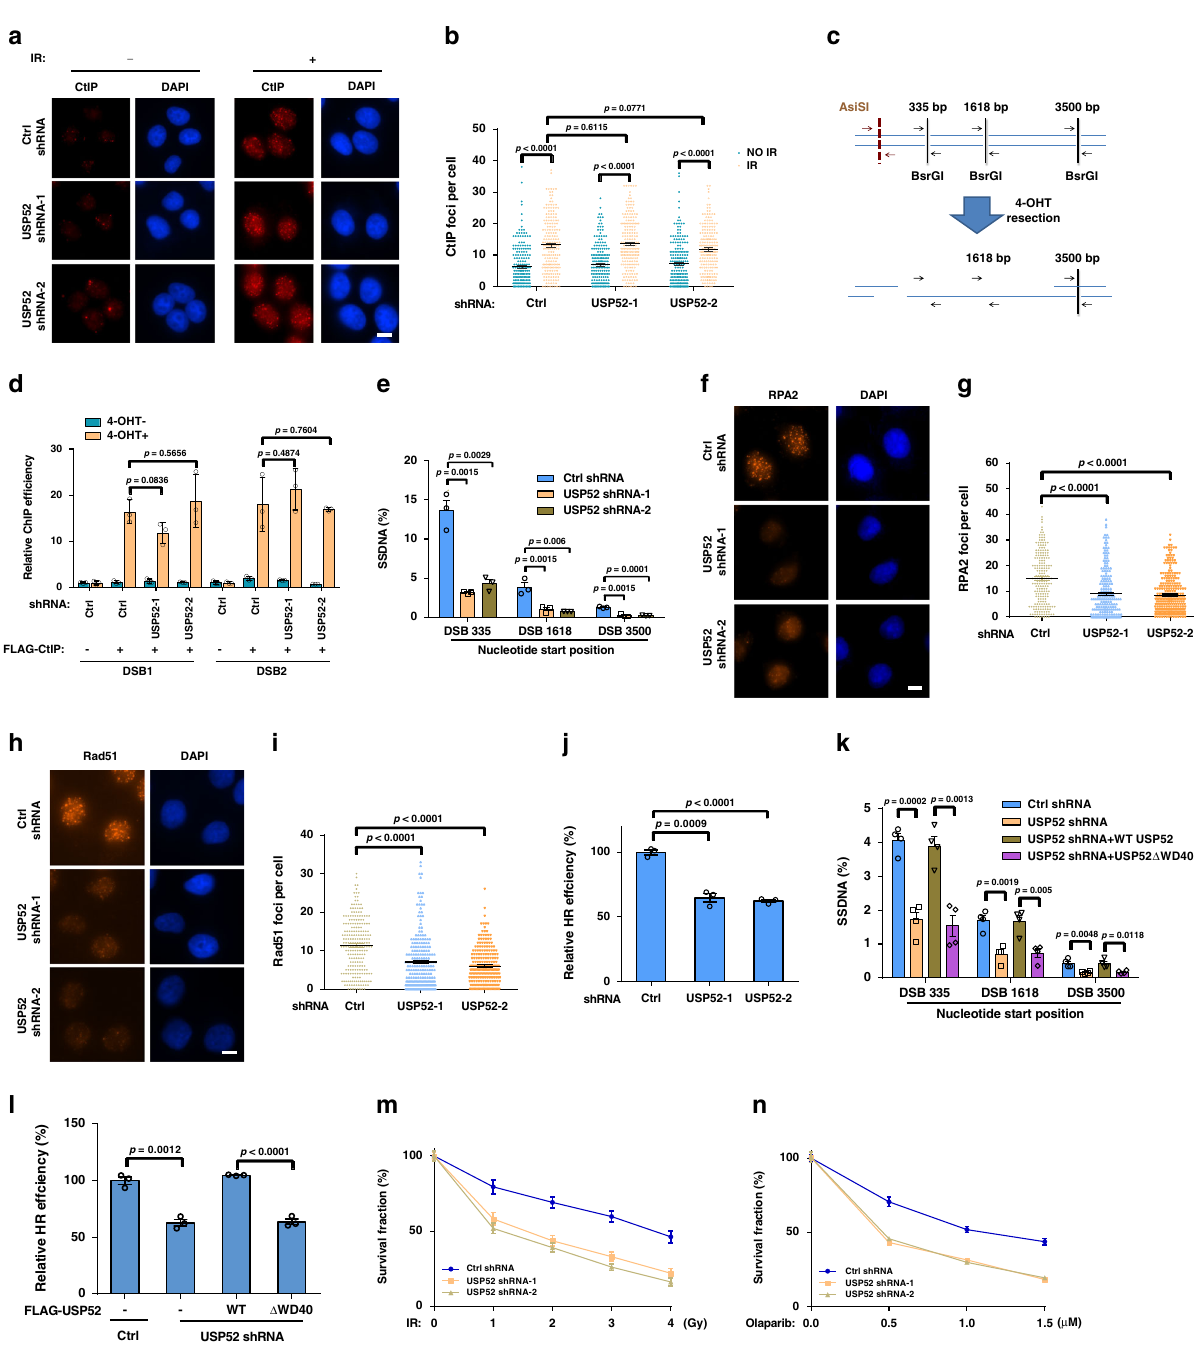
Fig. 2 USP52 promotes DNA end resection and HR repair. a , b , f – i Representative pictures ( a , f , h ) and quanti fi cations ( b , g , i ) of CtIP ( a , b ), RPA2 ( f , g ) and Rad51 ( h , i ) foci in control or USP52-depleted U2OS cells when treated with 5 Gy IR for 3 h, 2 Gy IR for 2 h or 5 Gy IR for 5 h, respectively. Data are representative of three independent experiments. Each dot represents a single cell, and more than 200 cells were counted in each group for this experiment. Error bars represent SEM from this experiment. Scale bar, 10 μ m. c Illustration of the designation of Taqman qPCR primers and probes (black arrows) for measuring resection at sites adjacent to the AsiSI sites (red arrows). The primer pairs are across BsrGI restriction sites. All Taqman probes are designed at either side of the restriction site. d Control or USP52-depleted ER-AsiSI U2OS cells transfected with FLAG – CtIP were added with or without 4- OHT. ChIP assay was then performed using FLAG antibody. e The genomic DNA extracted from control or USP52-depleted ER-AsiSI U2OS cells were digested with BsrGI. DNA end resection adjacent to DNA double-strand break sites was measured by qPCR assay. j The HR-mediated DSB repair ef fi cacy of control and USP52 depletion in HEK293T cells were analyzed using HR reporter. Data are presented as mean values ± SEM from three independent experiments. k Control or USP52-depleted ER-AsiSI U2OS cells transfected with indicated constructs were used for DNA end resection assay. Data are presented as mean values ± SEM from four independent experiments. l The ef fi cacy of HR in control or USP52-depleted HEK293T cells transfected with indicated USP52 constructs were analyzed using GFP reporter assay. m , n Control or USP52-depleted U2OS cells were exposed to the indicated dose of IR ( m ) or PARPi ( n ) for 2 weeks, colony formation assay was then performed to detect the survival rate of cells. d , e , j , l – n Data are presented as mean values ± SEM from three independent